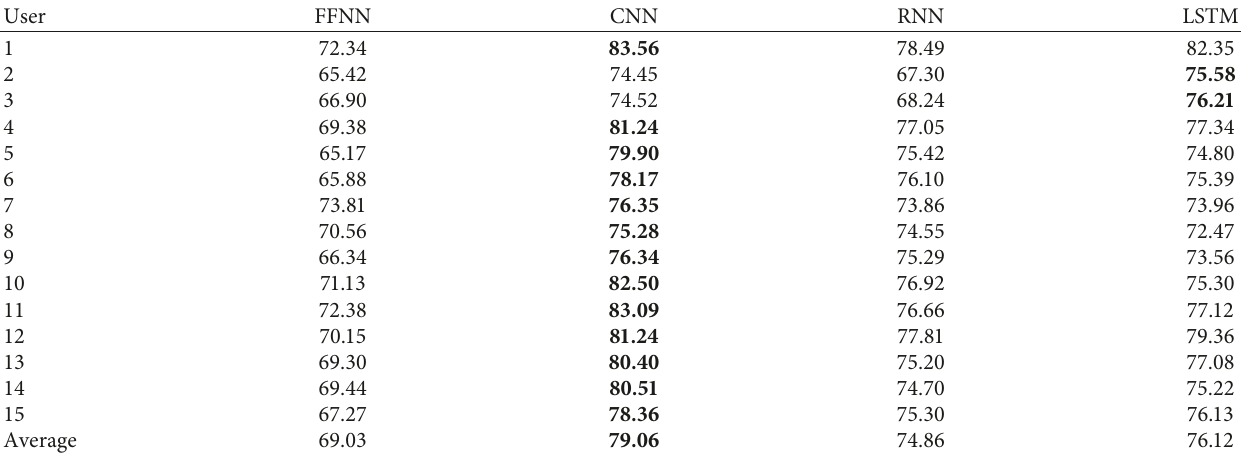
Table 5: Accuracy percentages of deep learning algorithms in terms of each